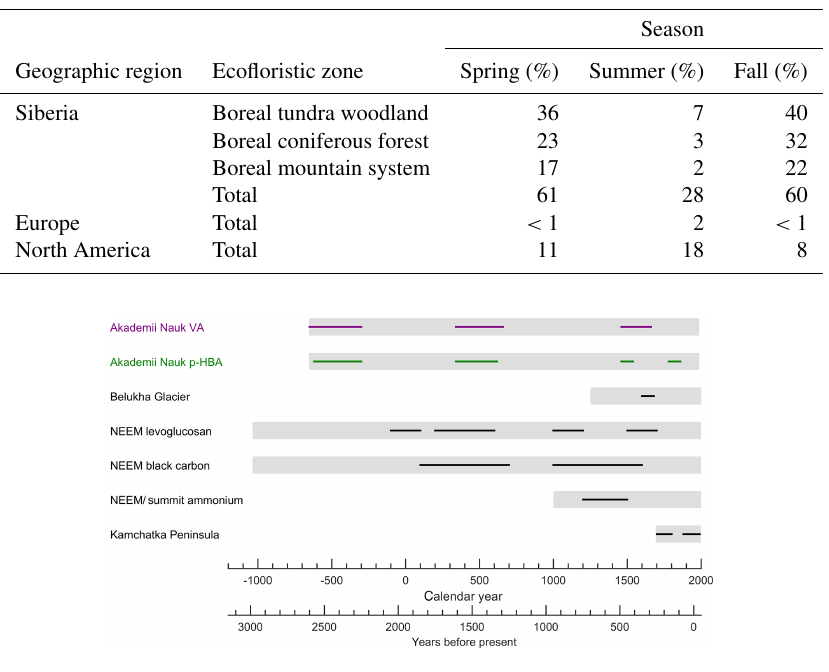
Figure 7. Timeline of elevated burning periods in Northern Hemisphere ice core studies. From top: Akademii Nauk vanillic acid and para - hydroxybenzoic acid (this study); Belukha glacier nitrate, potassium, and charcoal (Eichler et al., 2011); NEEM levoglucosan and black carbon (Zennaro et al., 2014); NEEM and Summit ammonium (Legrand et al., 2016; Zennaro et al., 2014); and Kamchatka Peninsula para -hydroxybenzoic acid, vanillic acid, dehydroabietic acid, and levoglucosan (Kawamura et al., 2012). Lines indicate periods of elevated burning. Gray bars mark the time range analyzed in each